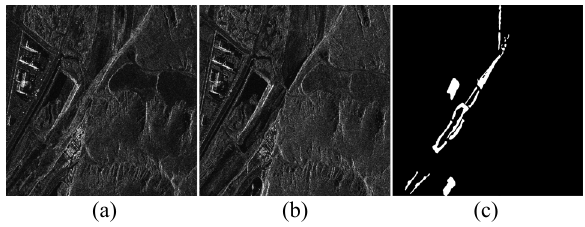
Figure 4. SAR change detection images of the real SAR image pair estimated using different estimators. (a) ˆ